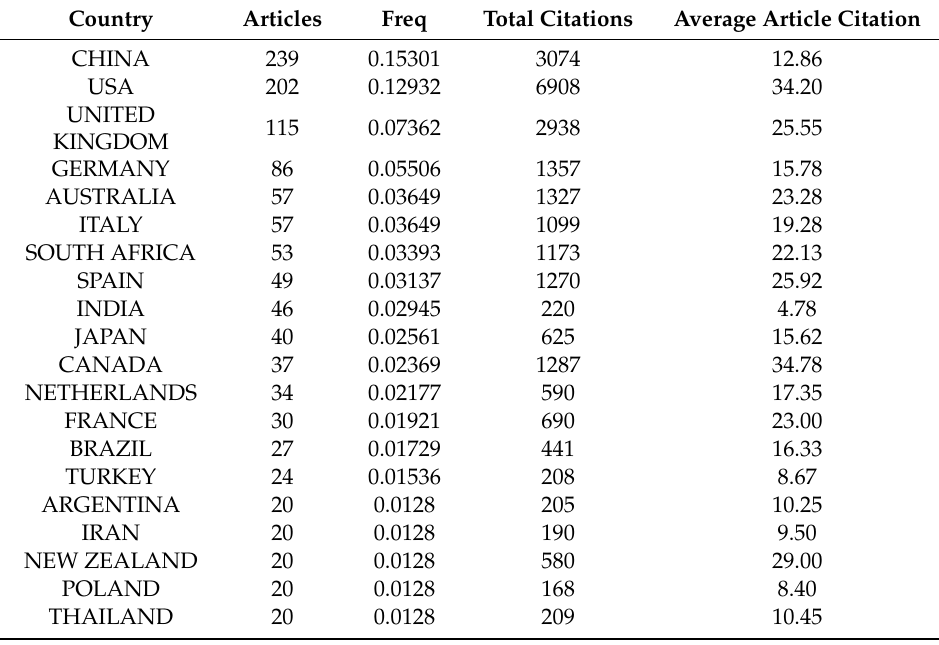
Table A1. Main countries’ paper status in the field of land degradation during 1990 to 2019.